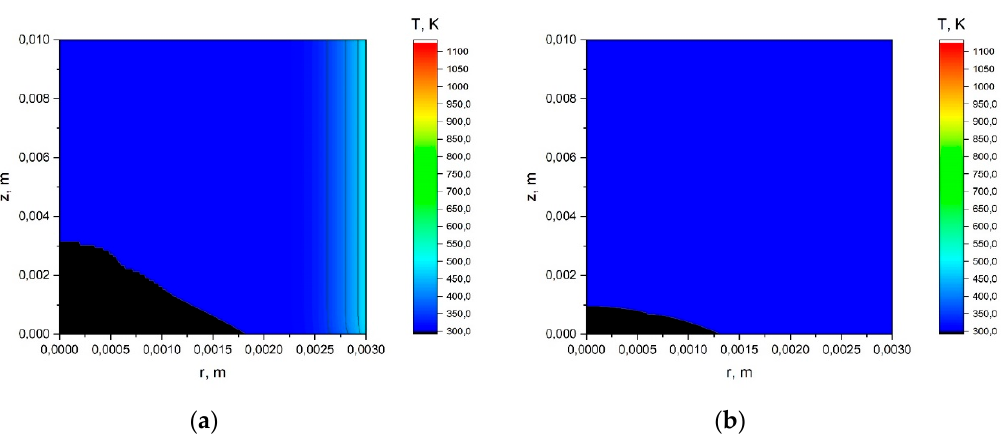
Figure A11. Temperature distribution in the stem of a herbaceous plant: R = 0.003 m, t = 0.5 s, q = 30 kW/m 2 ( a ); R = 0.003 m, t = 3 s, q = 0.5 kW/m 2 ( b ).